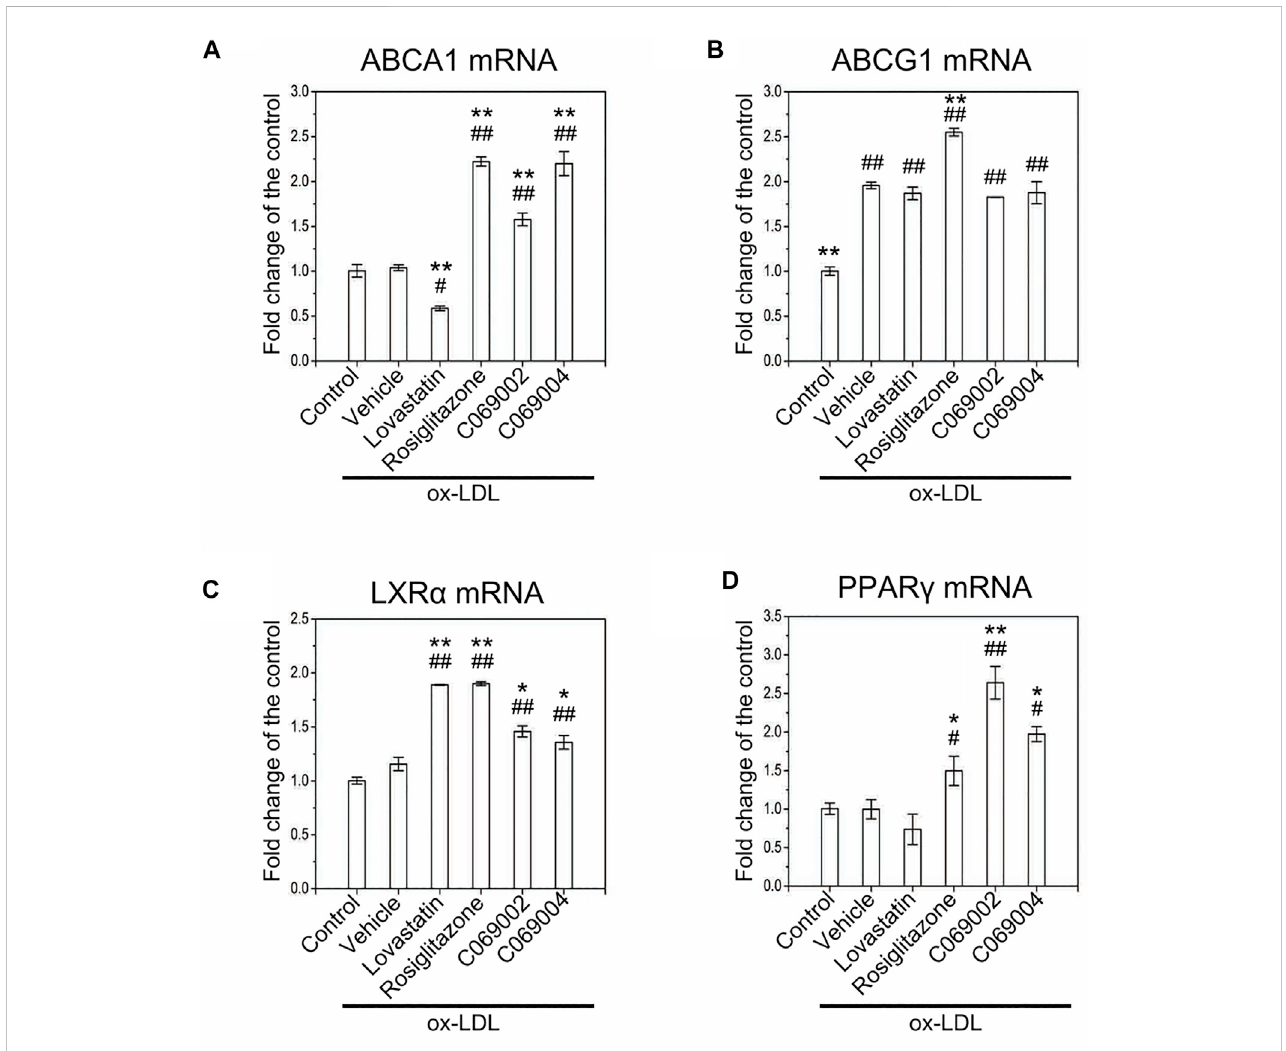
Treatment with diterpenoids increases the mRNA expression of ABCA1, LXR α , and PPAR γ in ox-LDL-induced macrophage foam cells. RAW264.7 macrophages were treated with 15 μ mol/L indicated compounds and 80 μ g/mL ox-LDL for 24 h. Total RNA was extracted from the cells for quantitative real-time PCR (qRT ‒ PCR) analysis of the mRNA levels of ABCA1 (A) , ABCG1 (B) , LXR α (C) and PPAR γ (D) . Data are shown as the mean ± SEM from threeindependentexperiments.Signi fi canceispresentedas* p < .05,** p < .01 versus thevehicle(DMSO)groupand # p < .05, ## p < .01 versus thecontrol